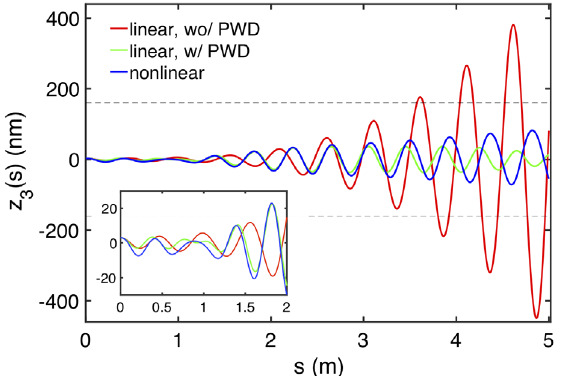
FIG. 4. Evolution of the most leading ( n ¼ 3 ) macroparticle along s based on three different cases. The slippage effect is included. The red curve is obtained from Eq. (21) with k s ¼ k s 0 ; the green curve from Eqs. (21) with k s given in Eq. (22); the blue curve from Eq. (17), where the potential-well effect is intrinsi- cally included. The inset shows a zoom for the oscillation in 0 < s < 2 m. Here the initial microbunch offsets assume ˆ z ð − 1 Þ n þ 1 × 3 nm ð n ¼ 0 ∼ 3 Þ , and the remaining parameters are the same as those assumed in Fig.